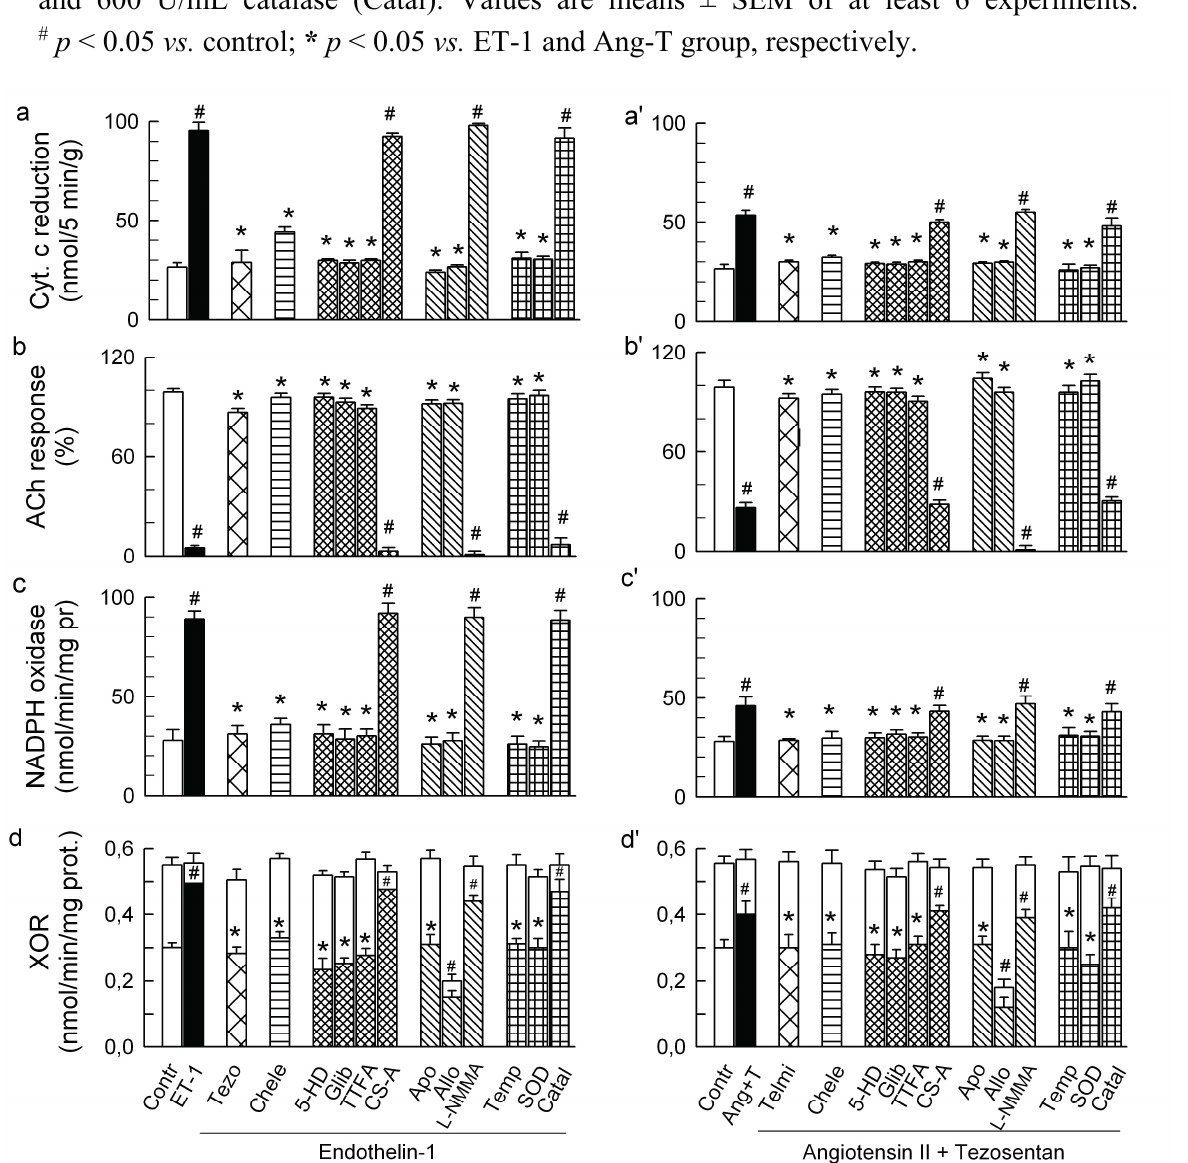
phosphorylation of p38 (Figure 4b,b') and ERK1/2 MAPKs (Figure 4c,c'); (v) neither ET-1 nor Ang-T